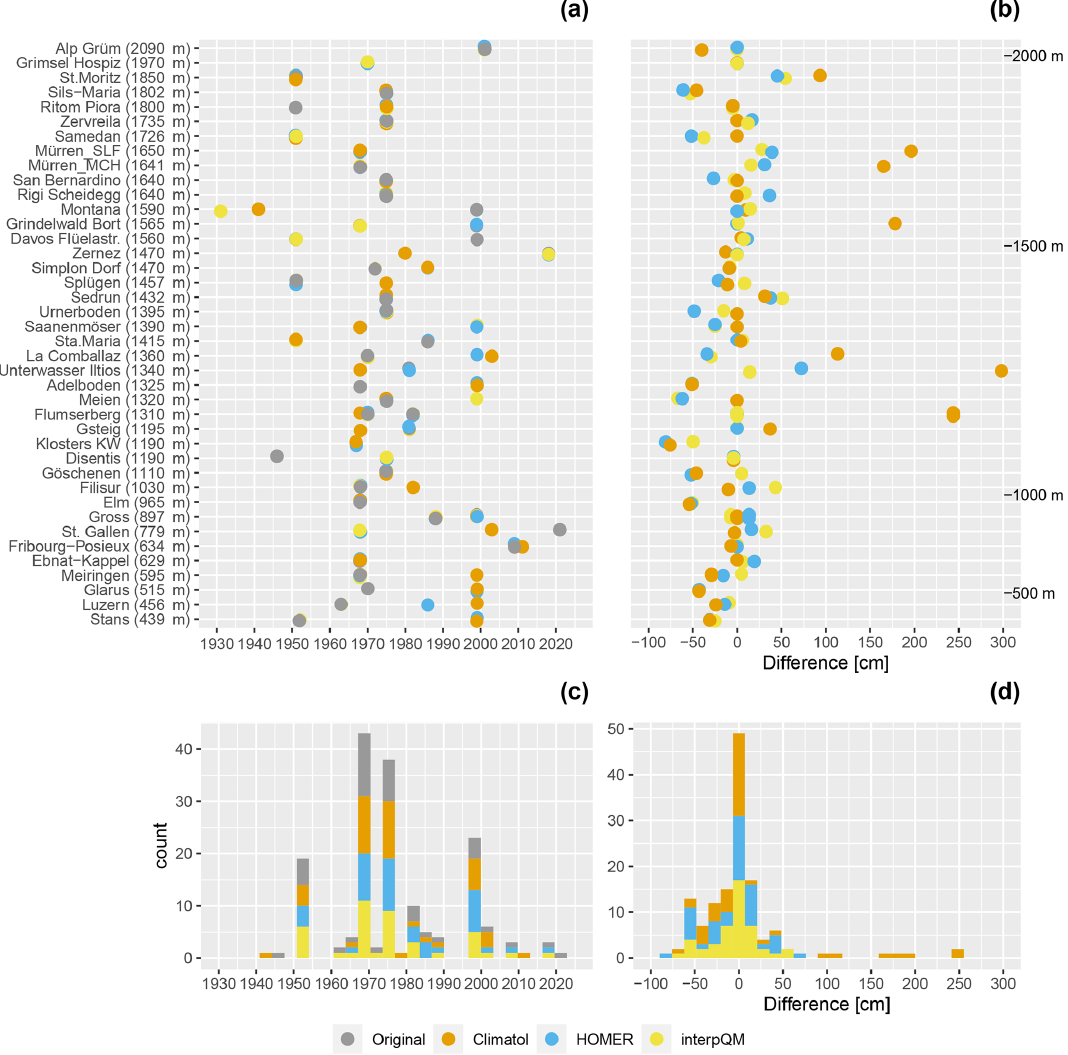
Figure 5. Maximum values of HSmax recorded for each station and method over the entire period (1961–2021). Panel (a) shows the year for which the absolute maximum snow depth is recorded. Panel (b) displays the differences between original and homogenised values. Panels (c) and (d) are the corresponding